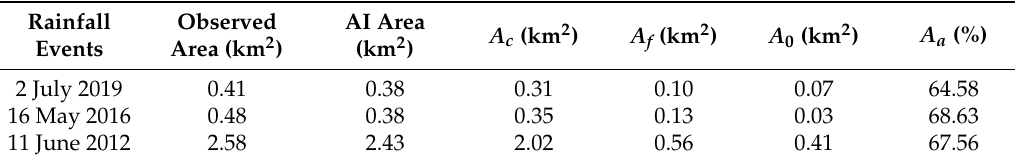
Table 4. AI platform accuracy of validation by critical success index (CSI)